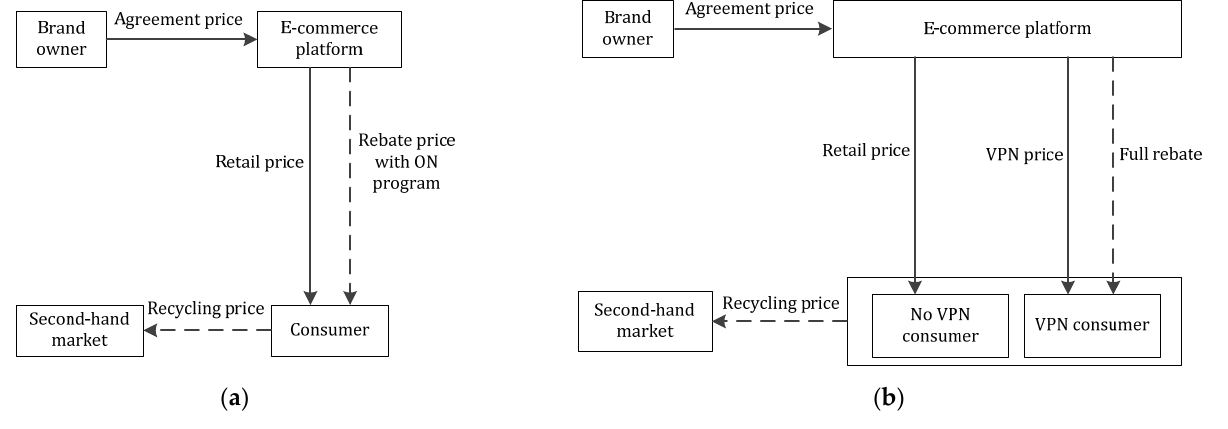
Figure 1. The model framework. ( a ) ON model; ( b ) VPN model.